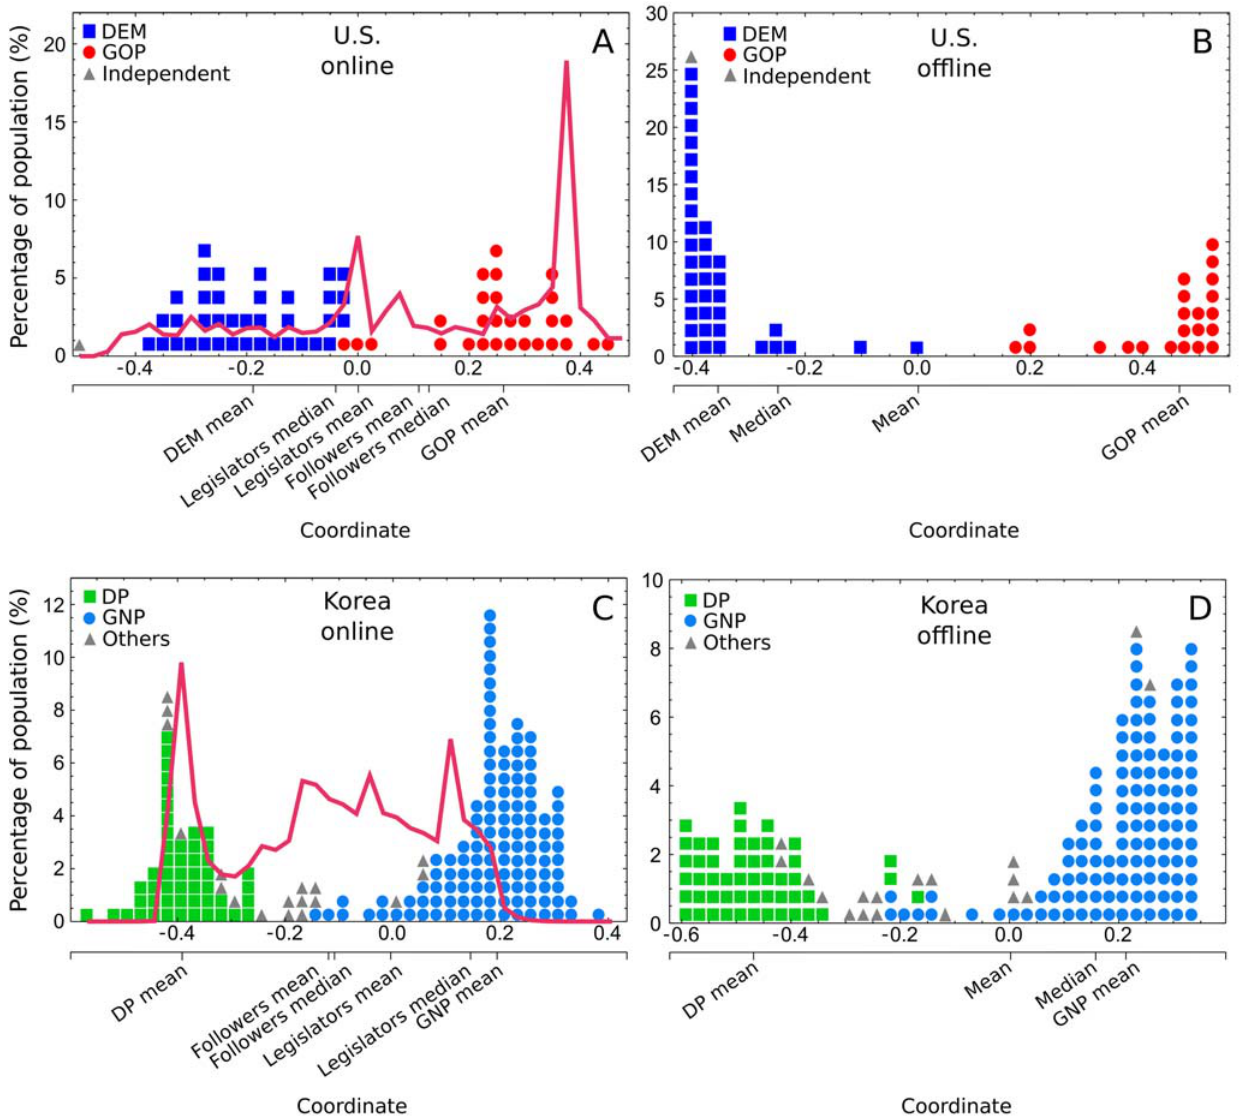
Fig 2. Political spectra determined from Twitter and roll call data. (A) The Twitter-based spectrum of the legislators, and the spectrum of Twitter users in the U.S.; (B) The roll call-based spectrum of the legislators in the U.S.; (C) The Twitter-based spectrum of the legislators, and the spectrum of Twitter users in Korea; (D) The roll call-based spectrum of the legislators in South Korea. The legislators are indicated by the shapes (one shape corresponds to one legislator) and the spectra of the Twitter users are indicated by solid lines. The party-line splits of the legislators are evident in both the Twitter- and the roll call-based spectra for both countries. The general Twitter public (solid lines in Fig 2A and C) show a majority-minority reversal, more people aligning themselves with the minority parties.